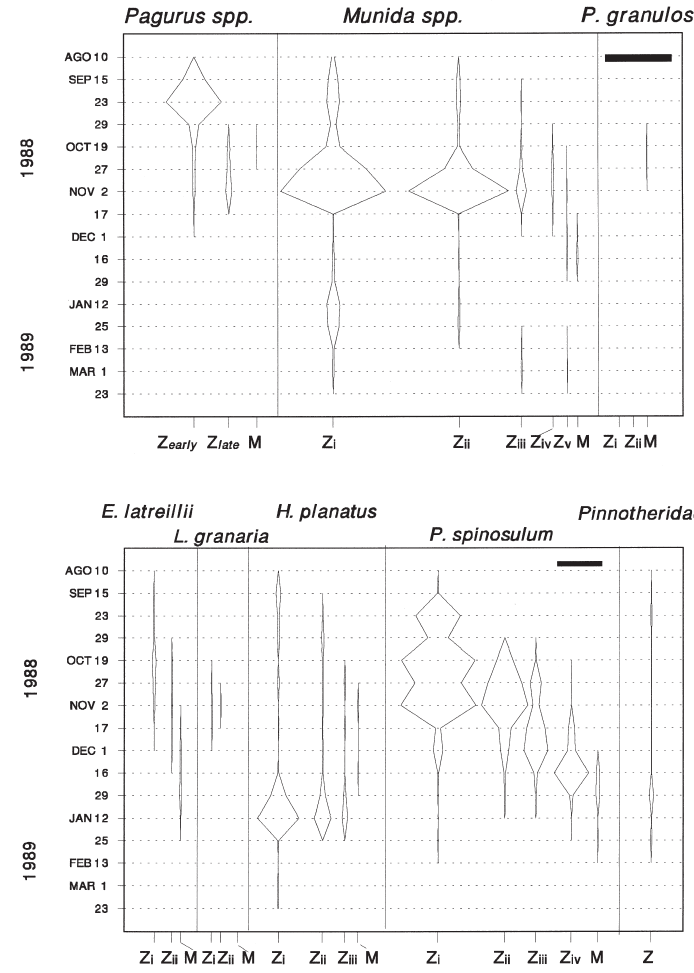
F IG . 3. – Average density of larval stages of the anomuran (above) and brachyuran (below) larvae in the Beagle Channel, Argentina. References: Z: zoea; M: megalopa. The scale bar represents 100 individuals · 10 m -3